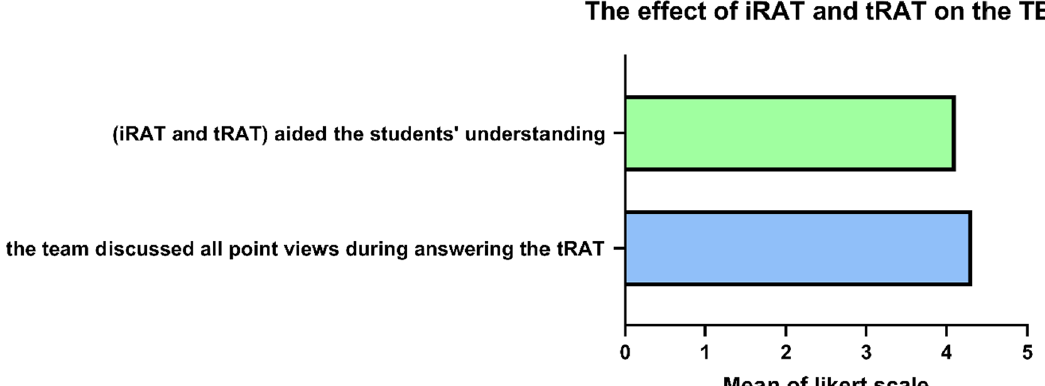
Fig. 2 The effect of iRAT and tRAT on TBL. Data are presented as mean Readiness Assessment Test, TBL: team-based learning, where 1 is the least and 5 is the